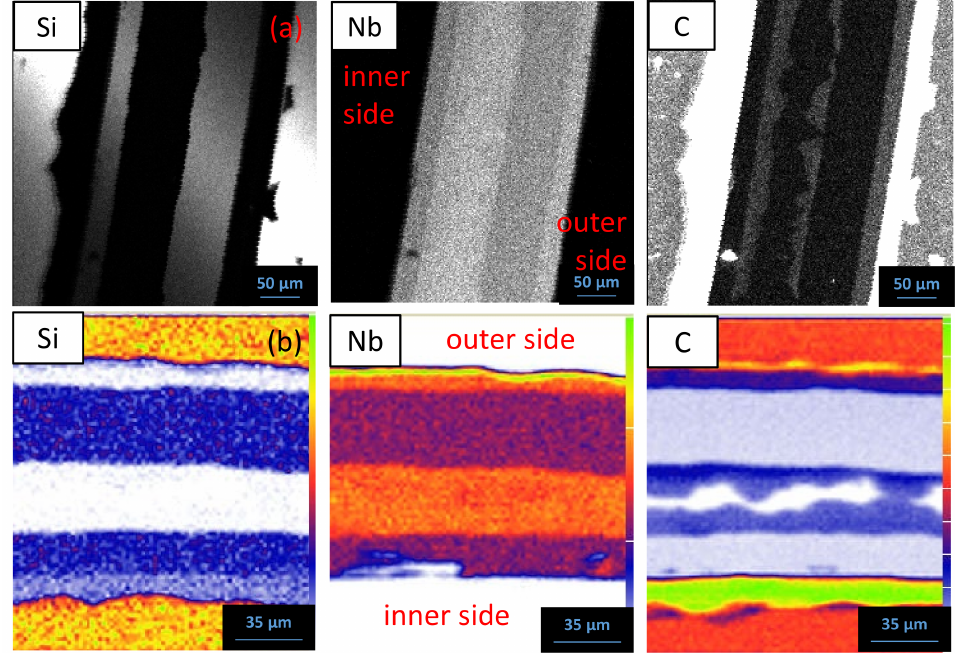
Figure 9. EPMA mapping ( a ) and and ion beam analyses ( b ), NRA for Si and C and PIXE for Nb, of the reaction zone of a Nb sandwich cladding after 1000 h at 1200 ◦